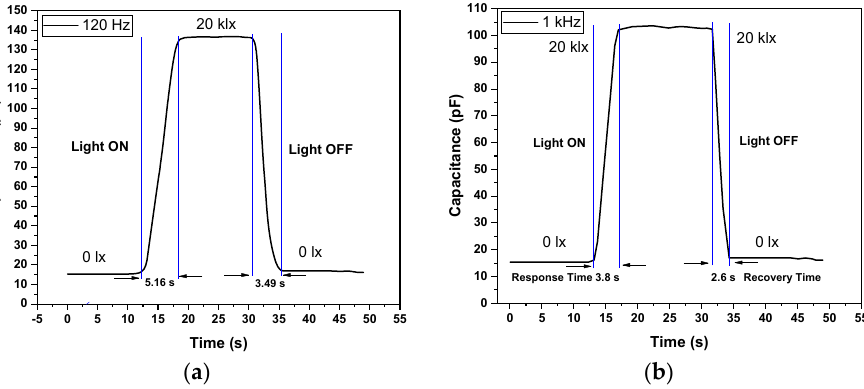
Figure 11. Response/recovery curve of Ag/PAD/Ag light sensor at ( a ) 120 Hz and ( b ) 1 kHz. Table 2. Comparison of present work with literature.